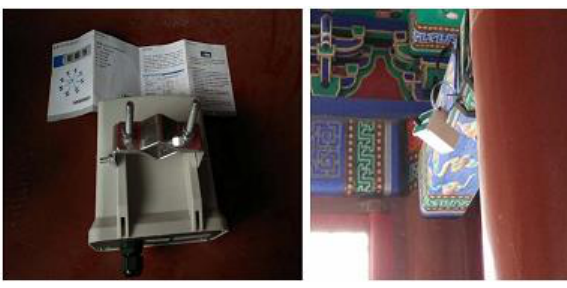
Figure 5. The data transmission apparatus